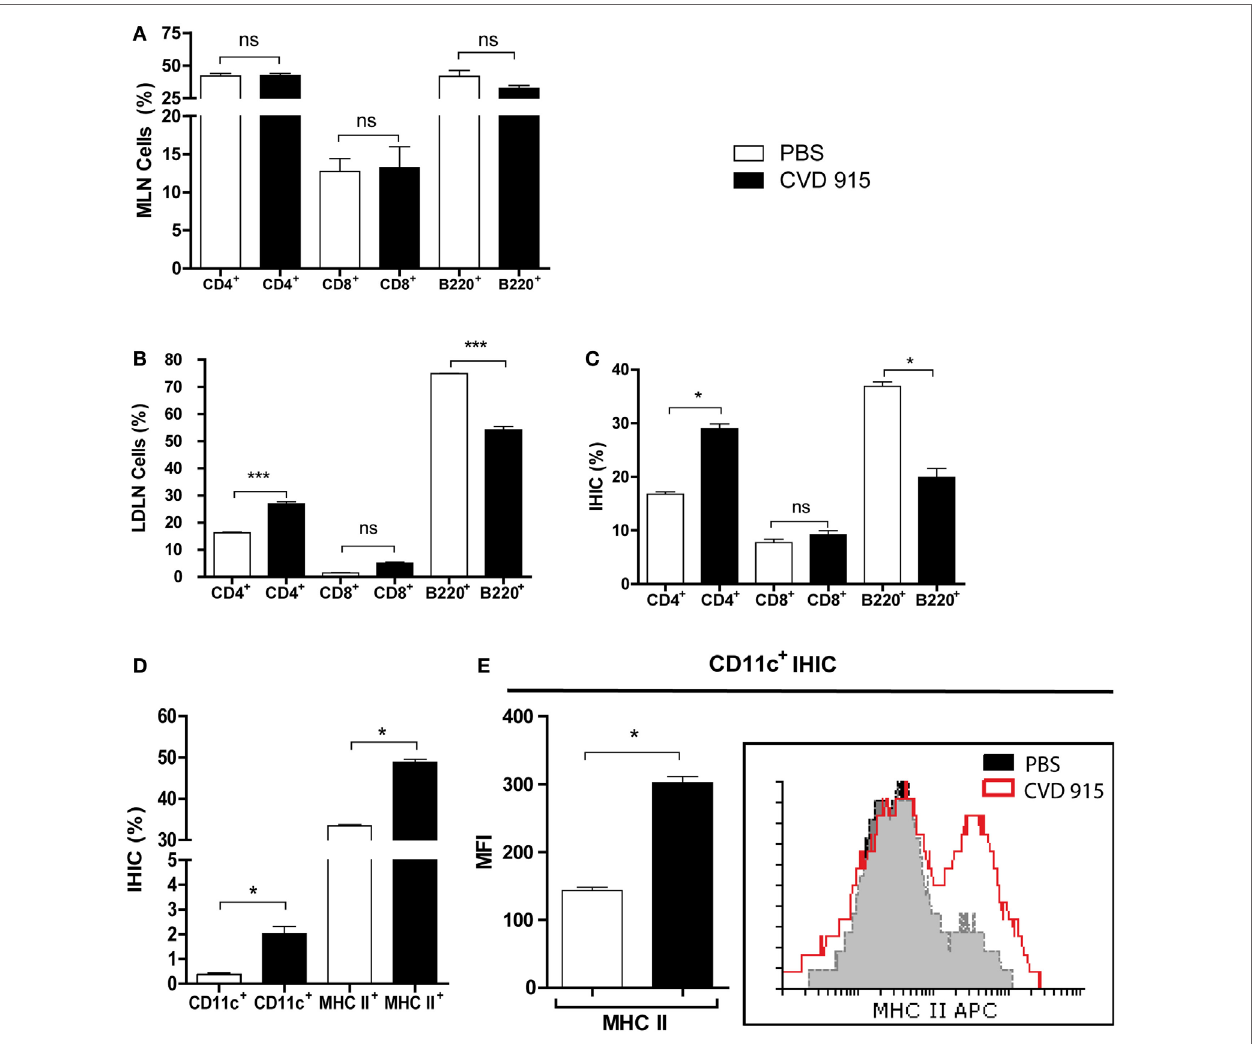
FigUre 3 | enhance cellular immune response in the liver and lnDn after cancer treatment with oral Salmonella . Twenty-one days after treatment with CVD 915 or PBS, livers, mesenteric lymph nodes (MLN) and liver draining lymph nodes (LDLN) from tumor-bearing mice were analyzed by flow cytometry. (a) Percentages of CD4 + , CD8 + , and B220 + lymphocytes from MLN. (B) Percentages of CD4 + , CD8 + , and B220 + lymphocytes from LDLN. (c) Percentages of CD4 + , CD8 + , and B220 + lymphocytes from intrahepatic immune cells (IHIC). (D) Percentages of CD11c + and MHC II + cells between the IHIC. (e) Representative histograms showing expression of MHC class II on gated CD11c + DC from IHIC. Bar graph represents the median fluorescence intensity (MFI) of MHC II expression on CD11c + cells. (a–D) ns, not statistically significant, * p < 0.05, *** p < 0.0001. All data shown are mean values of three pooled samples from four to five animals per group and are representative of one to four